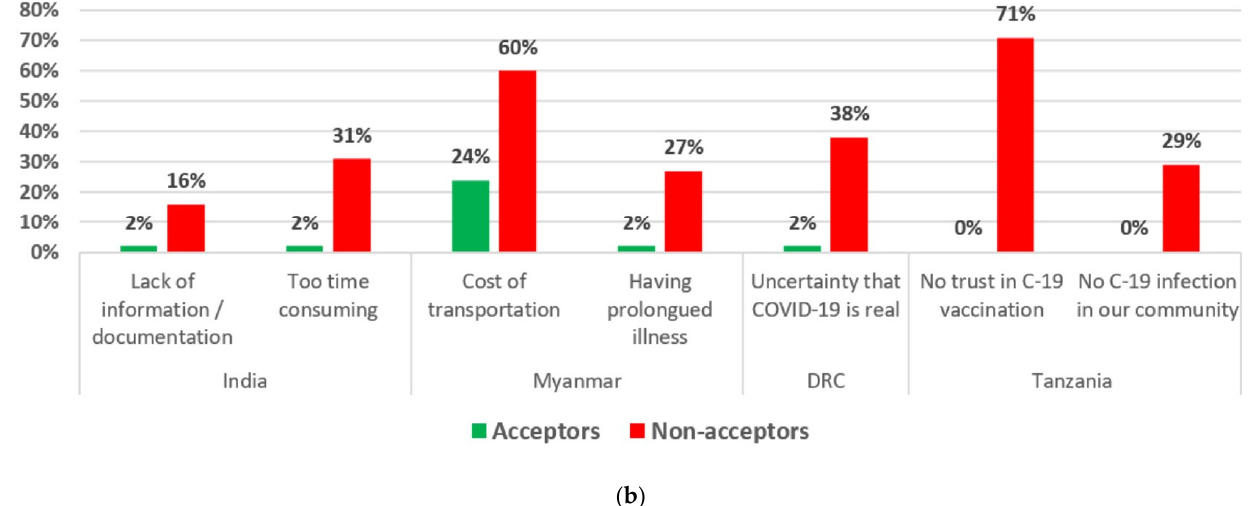
Figure 10. ( a ): What might make COVID-19 vaccination easier? ( b ): What might make COVID-19 vaccination difficult?